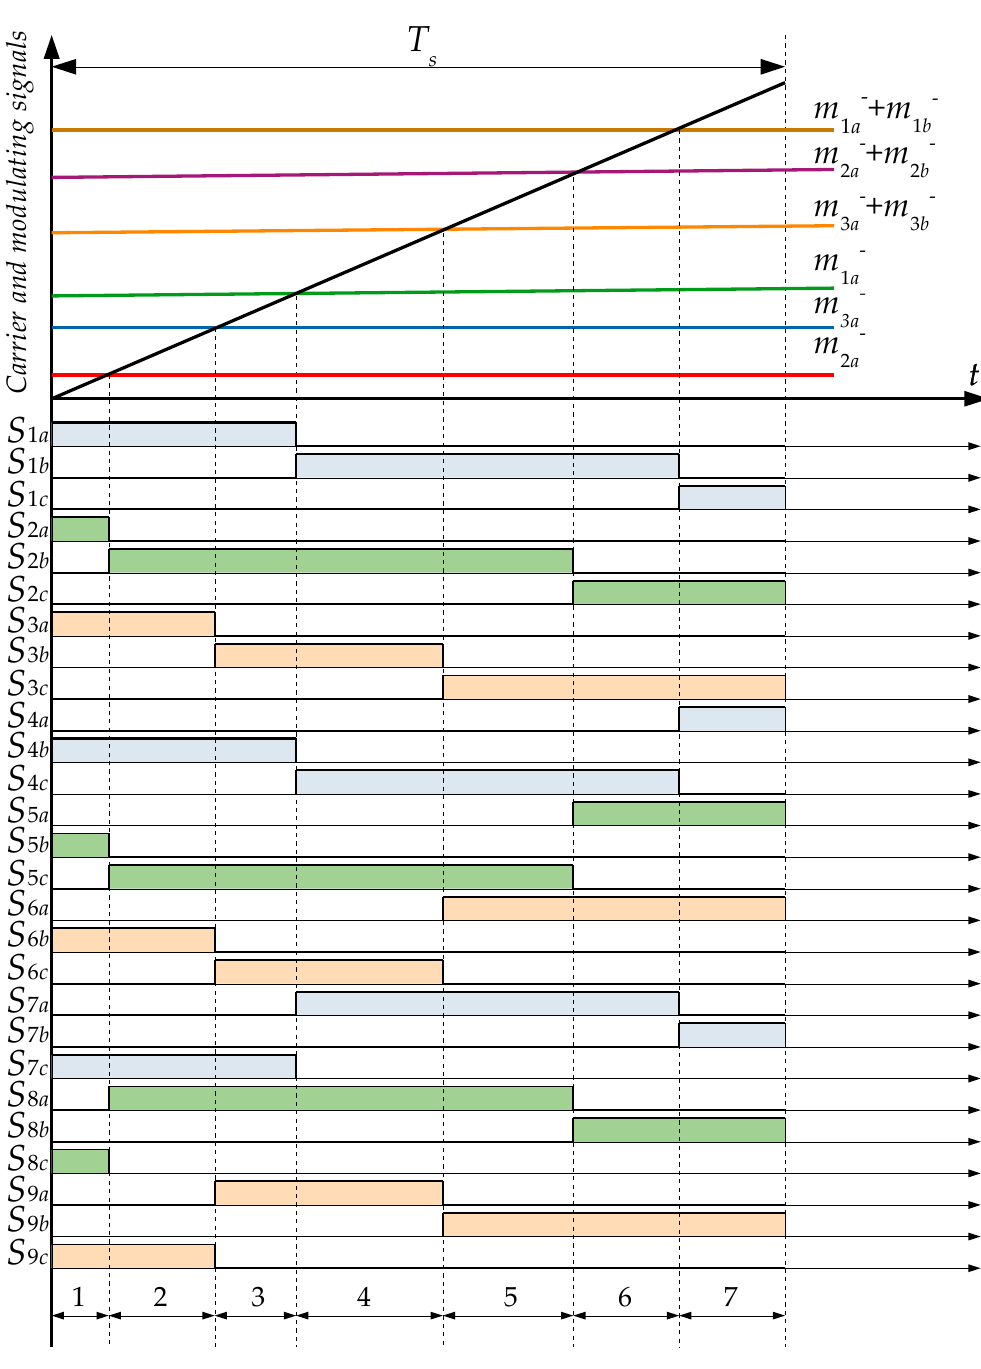
Figure 4. Switch duty cycles in the three-to-nine-phase MC for CCW method. Numbers from 1 to 7 respond the rotating voltage space vectors 𝑉(cid:4652)⃗ (cid:3028)(cid:3028)(cid:3028)(cid:3029)(cid:3029)(cid:3029)(cid:3030)(cid:3030)(cid:3030) , 𝑉(cid:4652)⃗ (cid:3028)(cid:3029)(cid:3028)(cid:3029)(cid:3030)(cid:3029)(cid:3030)(cid:3028)(cid:3030) , 𝑉(cid:4652)⃗ (cid:3028)(cid:3029)(cid:3029)(cid:3029)(cid:3030)(cid:3030)(cid:3030)(cid:3028)(cid:3028) , 𝑉(cid:4652)⃗ (cid:3029)(cid:3029)(cid:3029)(cid:3030)(cid:3030)(cid:3030)(cid:3028)(cid:3028)(cid:3028) , 𝑉(cid:4652)⃗ (cid:3029)(cid:3029)(cid:3030)(cid:3030)(cid:3030)(cid:3028)(cid:3028)(cid:3028)(cid:3029) , 𝑉(cid:4652)⃗ (cid:3029)(cid:3030)(cid:3030)(cid:3030)(cid:3028)(cid:3028)(cid:3028)(cid:3029)(cid:3029) and (cid:3030)(cid:3030)(cid:3030)(cid:3028)(cid:3028)(cid:3028)(cid:3029)(cid:3029)(cid:3029) , respectively. Simulation performed for output frequency 30 Hz and voltage transfer ratio k U = 0.5.